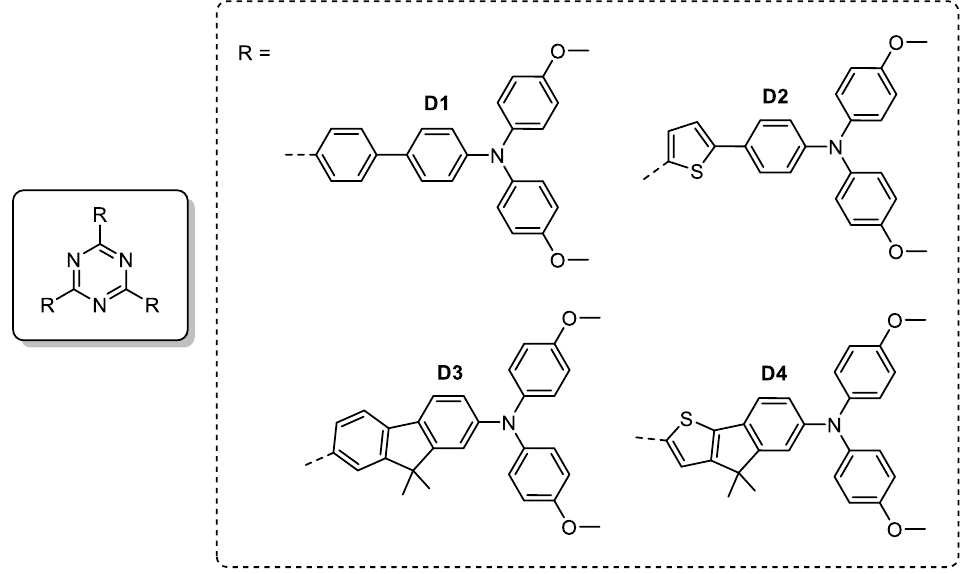
Figure 11. Chemical structures of triazine derivatives employed as HTMs in PCSs.